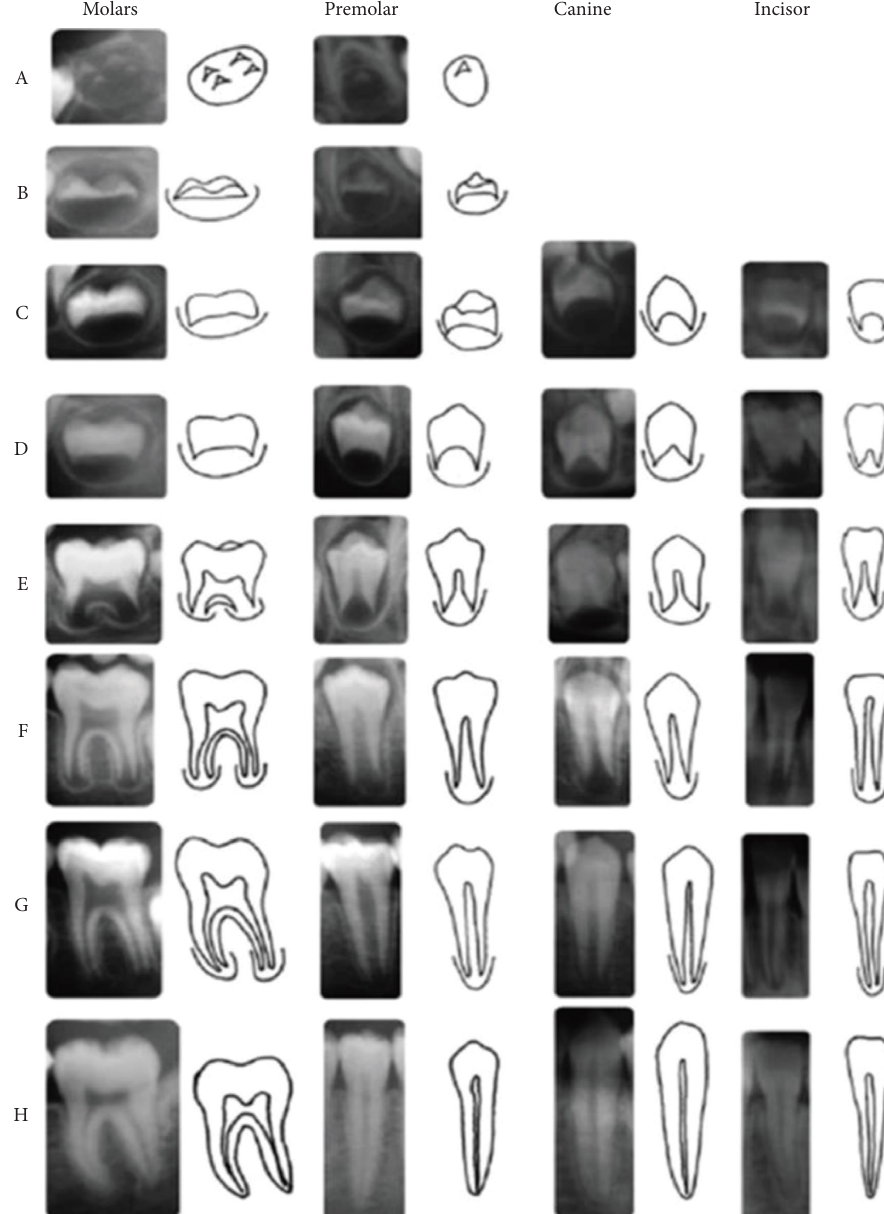
Figure 2: Demirjian’s method of determining dental growth stages for estimation of dental